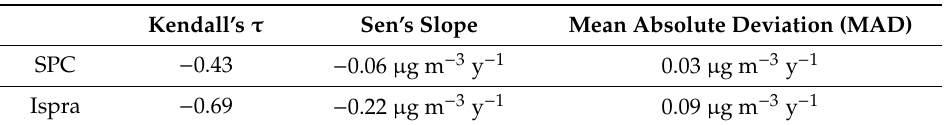
Table 2. Statistical parameters of Kendall rank correlation and Theil-Sen analysis for the EC time series at San Pietro Capofiume (SPC 1997–2016) and Ispra (2003–2016).